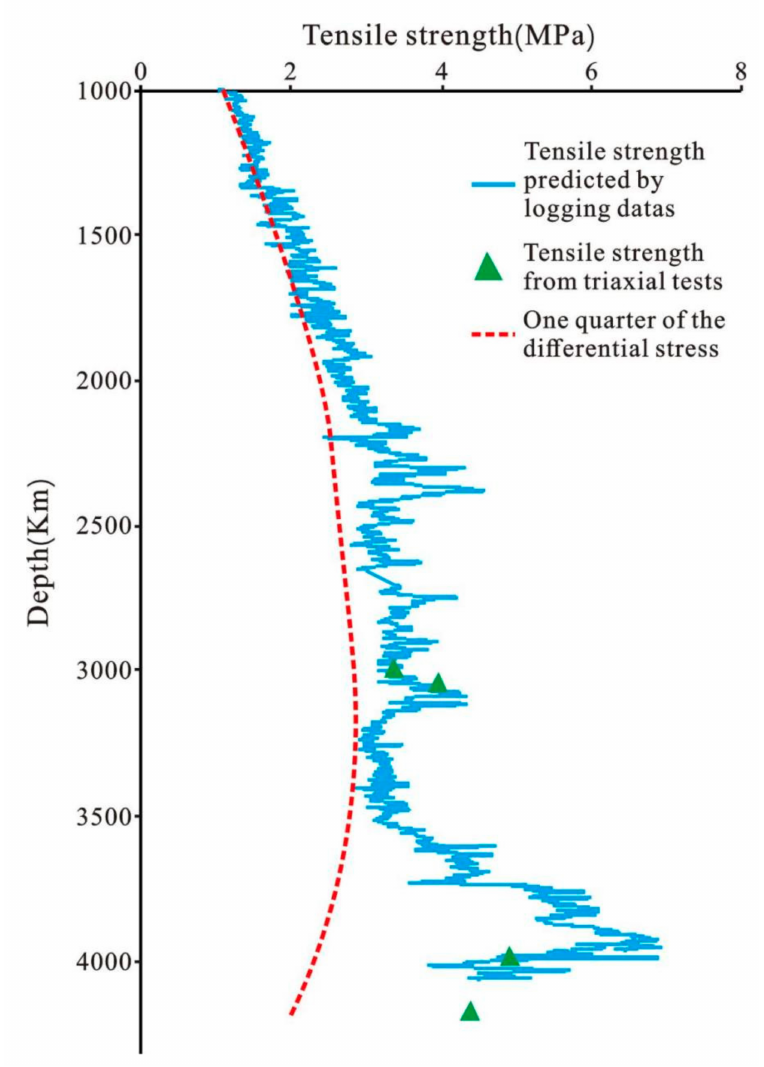
Figure 9. Prediction of tensile strength from the well XD-A1. The one quarter of the differential stress is always less than the tensile strength in the whole depth, it means that extensional fracture always occurs for the intact cap